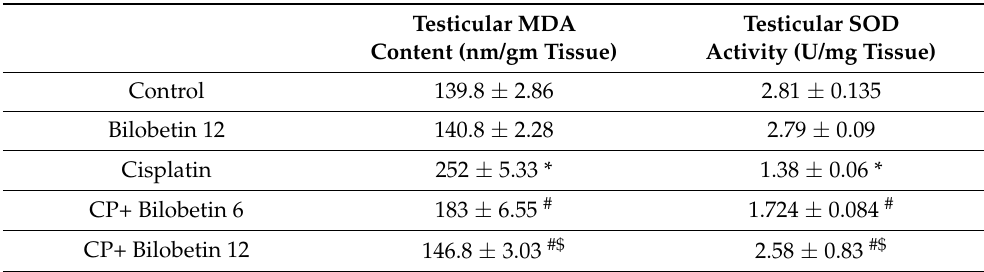
Figure 2. Effects of Bilobetin treatment on ( A ) Serum Testosterone level, ( B ) Cytochrome-C level, ( C ) Nrf2 gene expression level, and ( D ) Keap-1 gene expression level in CP-induced testicular toxicity in rats. CP-induced testicular damage was induced by a single i.p. injection of 7 mg/kg of CP on day 3. Rats were grouped randomly into the control group. Bilobetin group was administered Bilobetin (12 mg/kg) i.p. daily for ten days; untreated CP group and CP groups were treated with Bilobetin (6,12 mg/kg, respectively) i.p. daily for ten days and a single dose of i.p. injection of CP 7 mg/kg at day 3. Data expressed as mean ± SD (n = 8/group). Significant difference vs. * respective control; # respective CP group; $ respective CP+ Bilobetin 6 group each at p < 0.05. Table 3. Effects of Bilobetin treatment on testicular MDA level. Testicular SOD activity in Cisplatin- induced testicular toxicity in